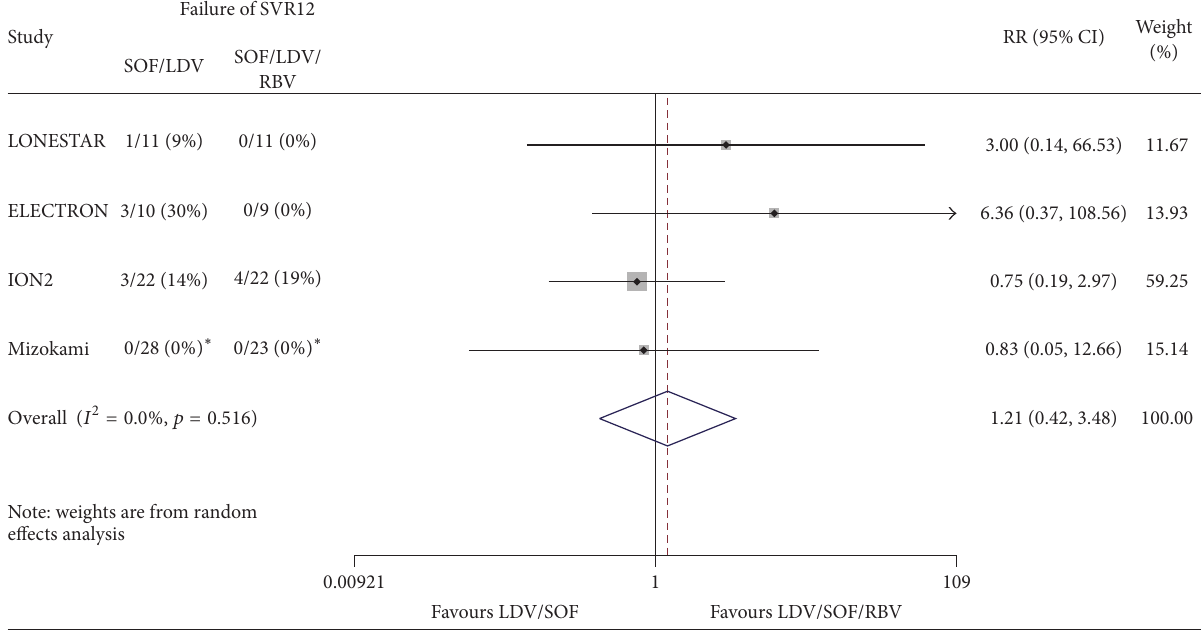
Figure 2: Forest plot of relative risks of not achieving SVR12 with 12 weeks of SOF/LDV versus SOF/LDV/RBV in chronic hepatitis C, genotype 1, of cirrhotic patients who have failed previous